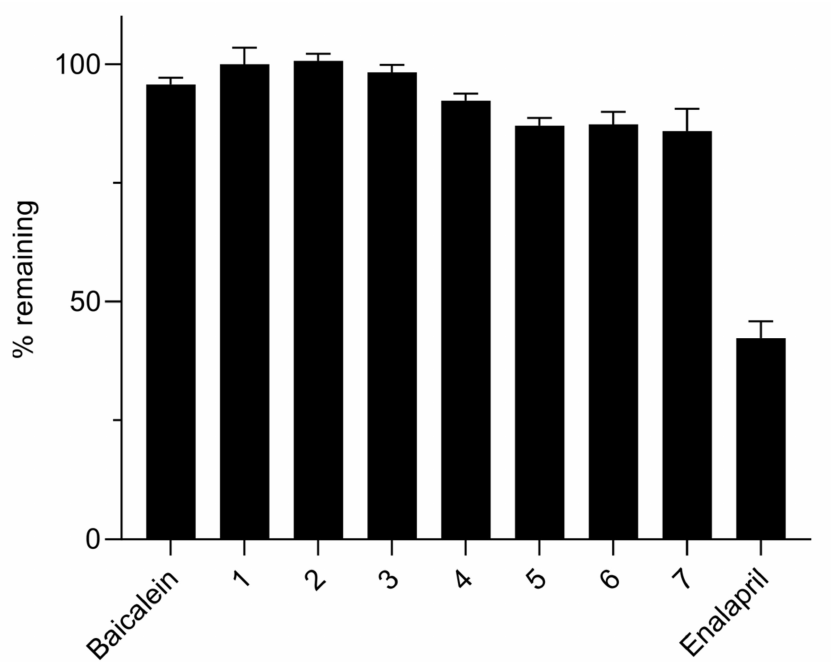
Figure 2. Stability of baicalein and its carbamate prodrugs in mouse plasma. Test compounds were incubated for 60 min at 37 ◦ C in mouse plasma. % remaining was determined at 60 min vs. time 0 using peak ratios of LC − MS/MS chromatograms. Data are expressed as the mean ± SD ( n =